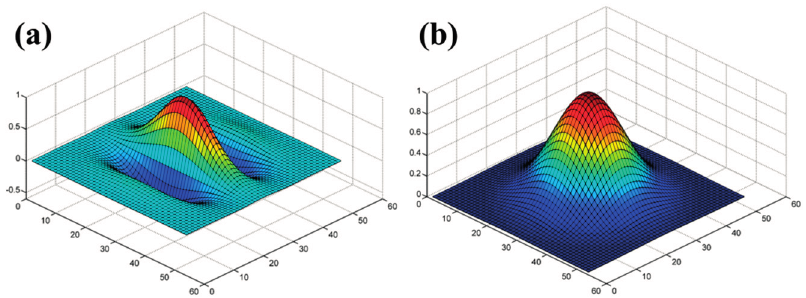
Figure 4. Gabor filter composition: ( a ) Real Gabor filter kernel oriented at an